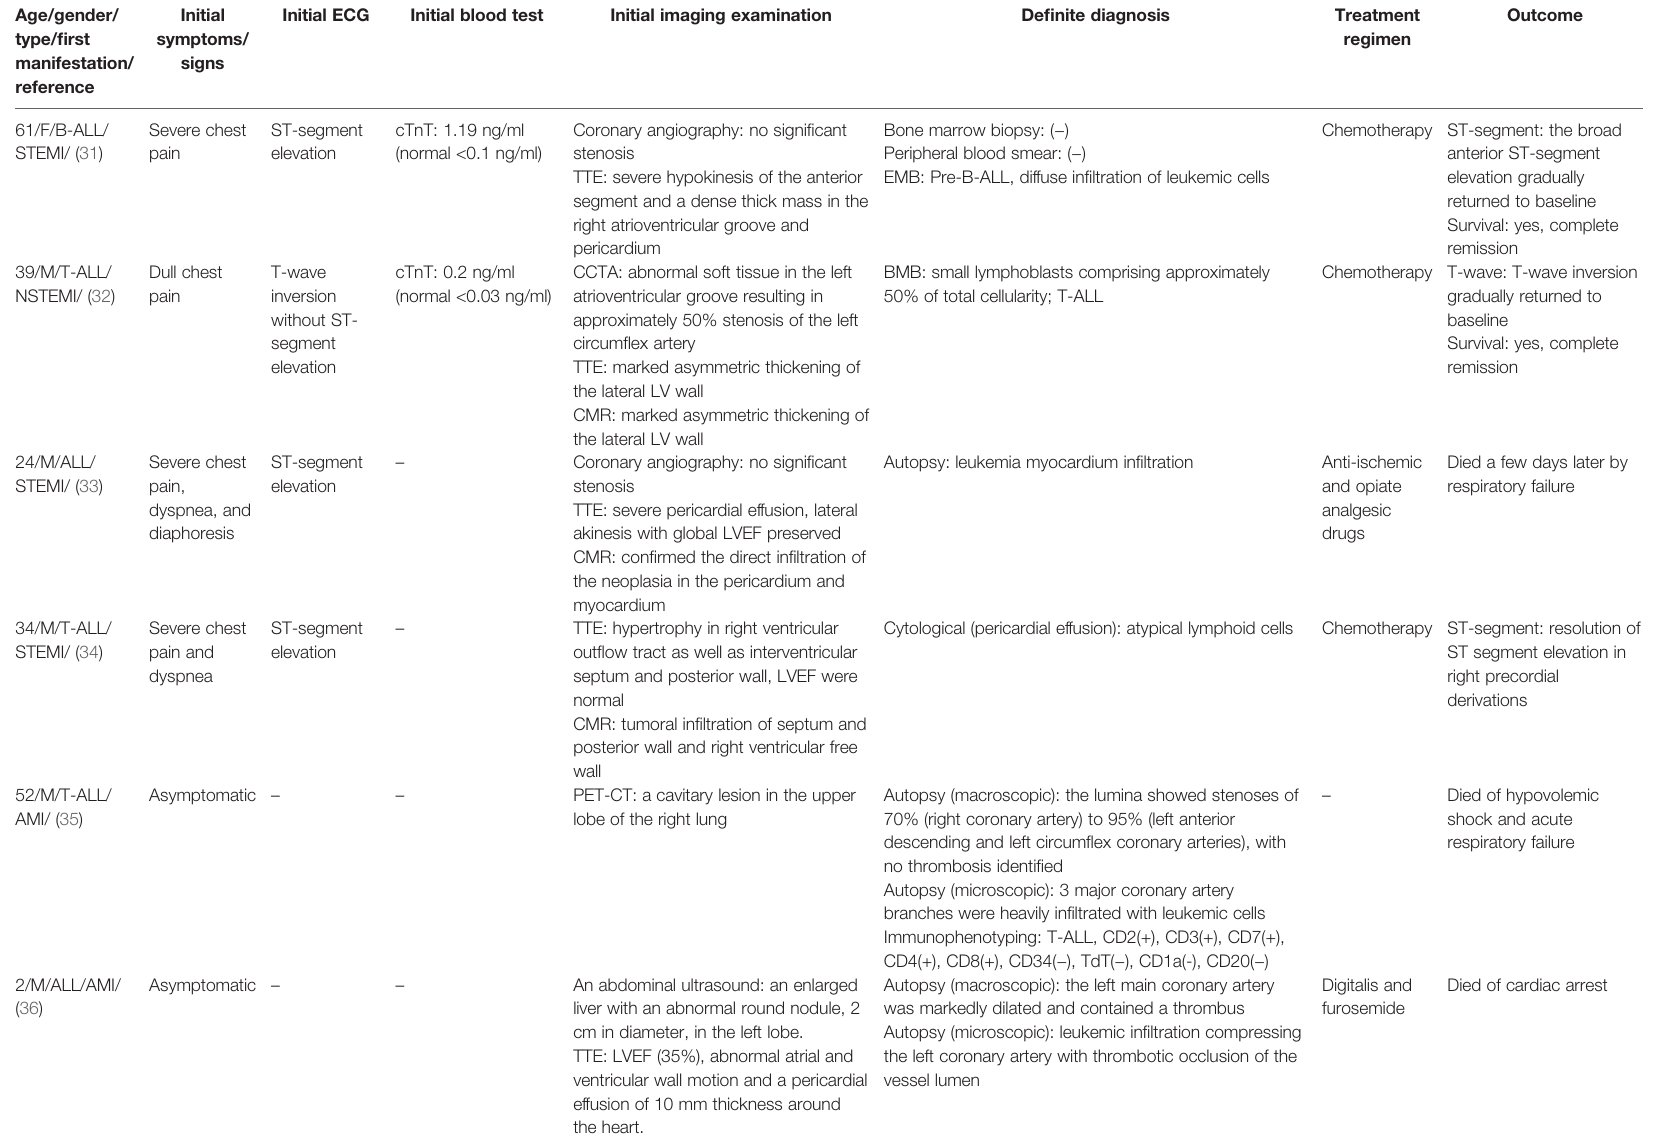
TABLE 4 | Acute myocardial infarction as fi rst manifestation of acute lymphoblastic